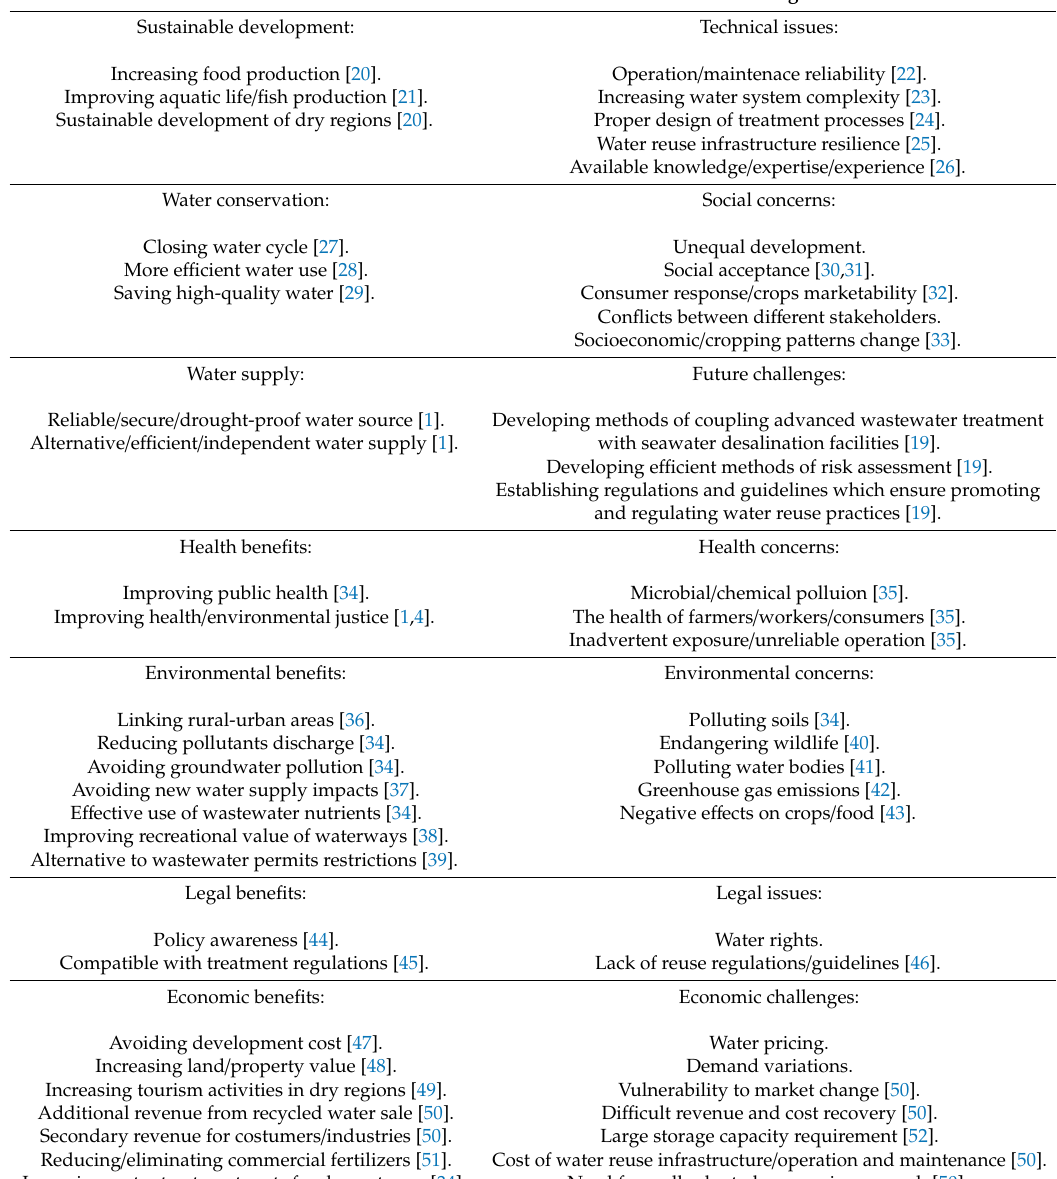
Table 1. Benefits and challenges of agricultural water reuse (adapted from [4] and modified). Benefits